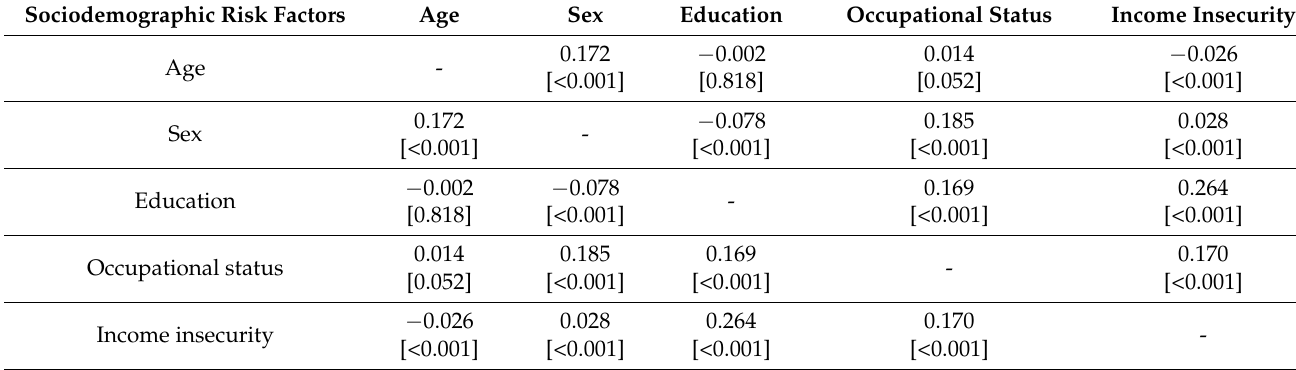
Table A1. Bivariate correlations between age group, sex, education, employment and income security.